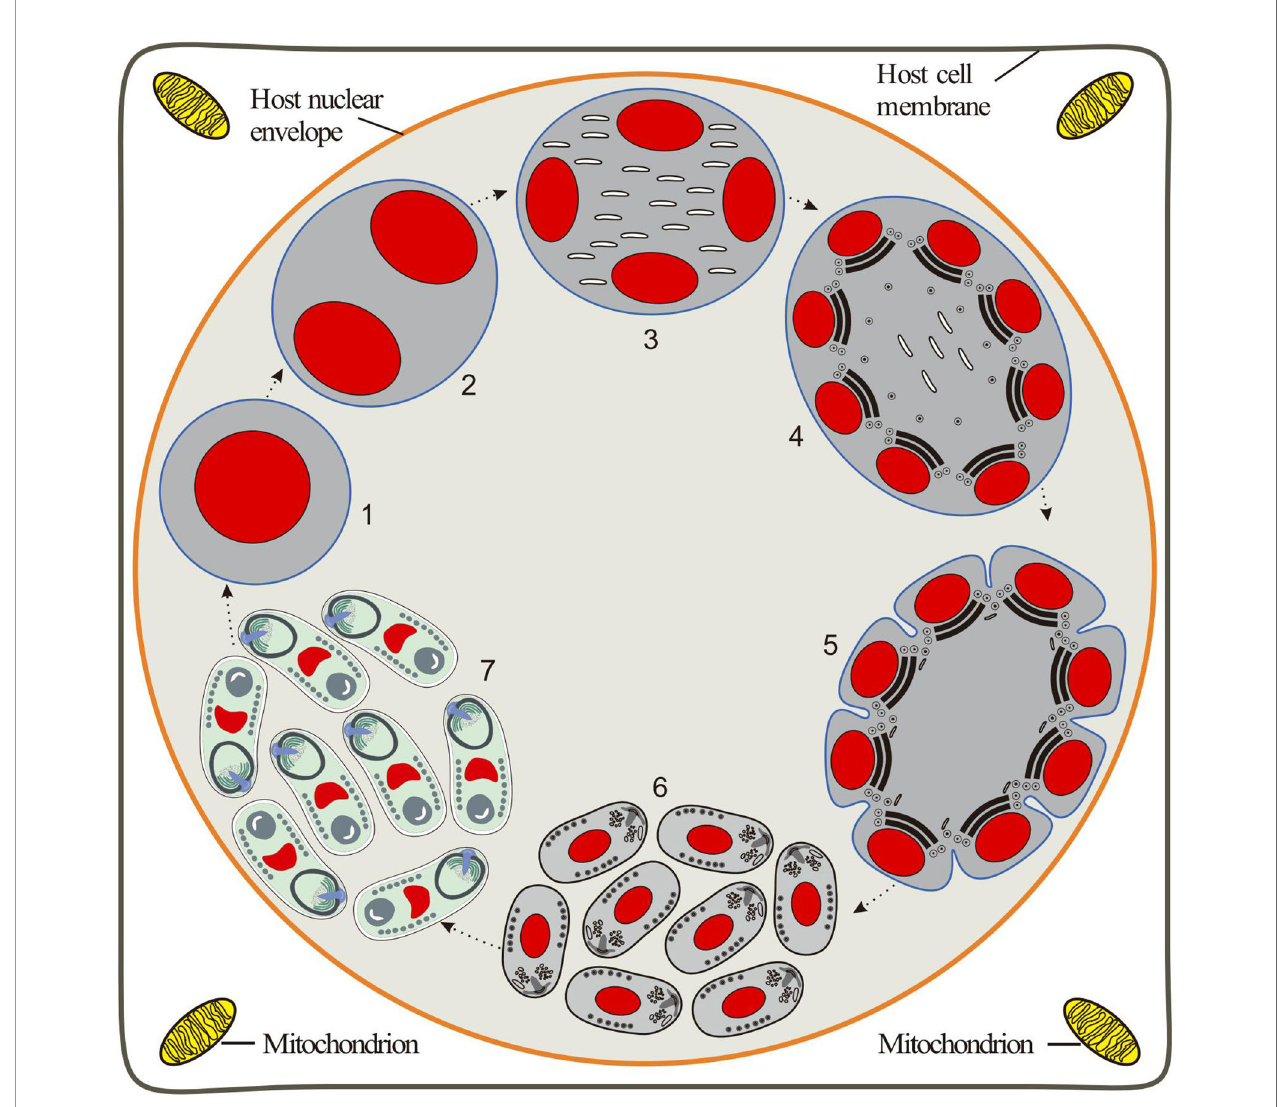
FIGURE 8 | Diagrammatic representation of the proposed intranuclear life cycle of Nucleospora hippocampi n. sp. (1) Uninucleate meront free in the host nucleus. (2) Binucleate meront formed by nucleus mitosis without cytokinesis. (3) The nuclear divides again to produce a tetra-nucleate meront with numerous claviform cytoplasm. (4) The proliferative sporogonial plasmodium shows electron-dense disks and eight units of polar tube precursors around the inner edge of its plasmalemma. (5) The syncytial sporogonial plasmodium produces eight uninucleate sporoblasts by rosette-like budding. The invagination of plasmalemma segregates each nucleus with polar tube precursors into each sporoblast. (6) The individual sporoblasts develop into immature spores. (7) Eight mature spores are formed in direct contact with the host nucleoplasm.